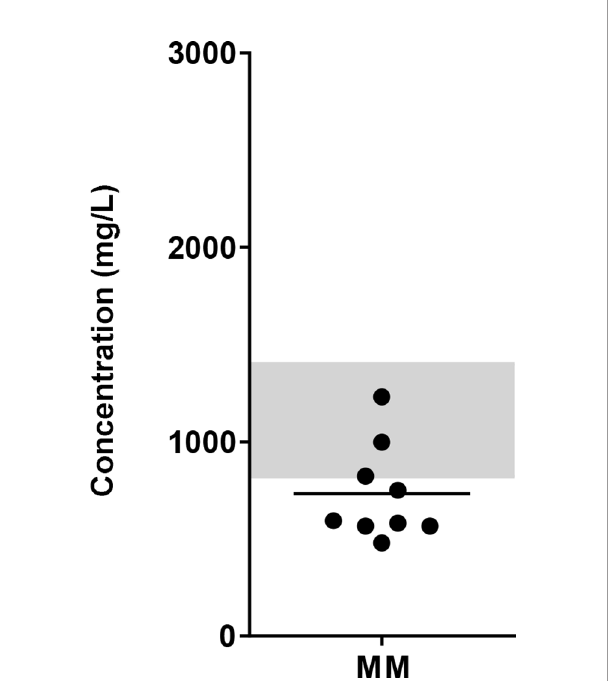
FIGURE 1 | Glucose concentration in the BM of MM patients. BM samples from newly diagnosed MM patients were collected and glucose concentrations were determined using biochemical analyzer (YSI). Grey bar indicates the reference value range for normal fasting blood glucose (4.4 – 6.1 mmol/L or 820 – 1100 mg/L up to 1400 mg/L postprandial). n = 9